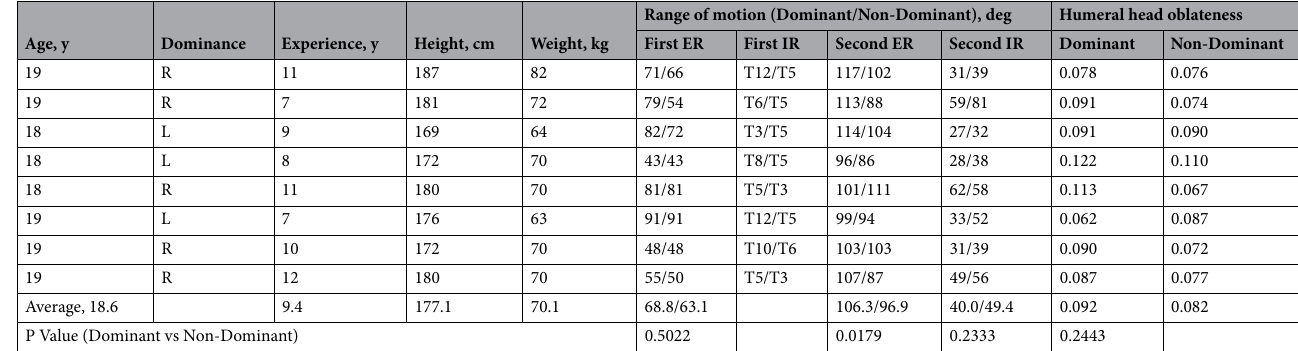
Table 1. Participant Characteristics. ER: External rotation. IR: Internal rotation. R: Right. L: Left. T: